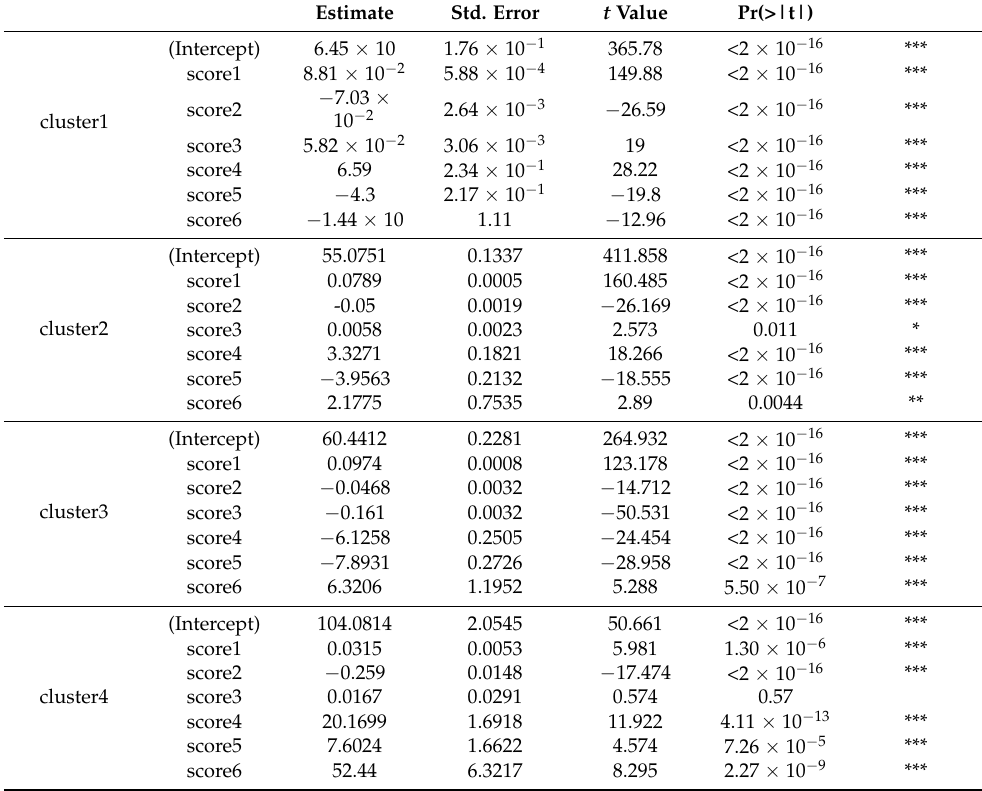
Table A2. Regression results of the clustered air pollution data given by the FCR-HL